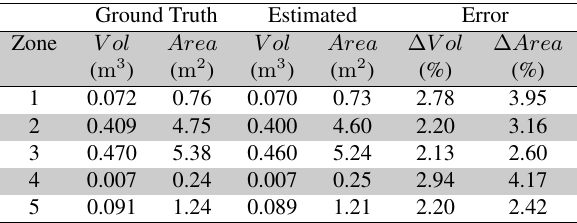
Table 2. Evaluation of volume and surface area estimation. Ground Truth